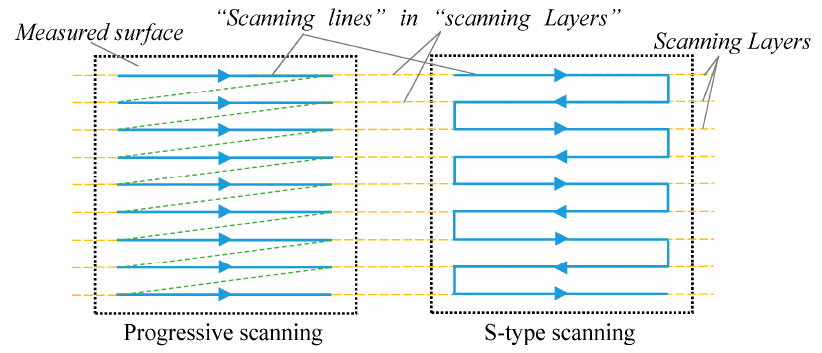
Figure 2. Layer-by-layer scanning path for 3D free-form surface scanning measurement.